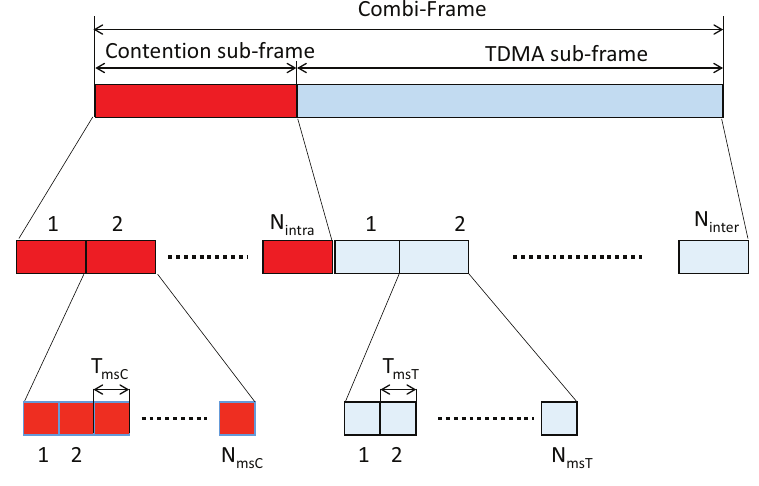
Figure 3. Combi-Frame